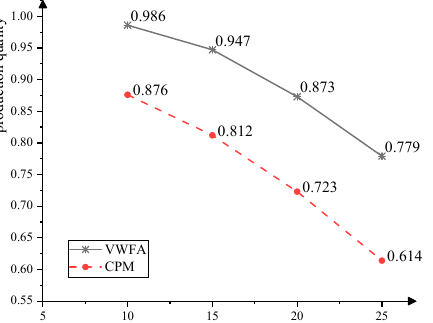
Figure 5. Impact of the number of process nodes on the algorithm VWFA.